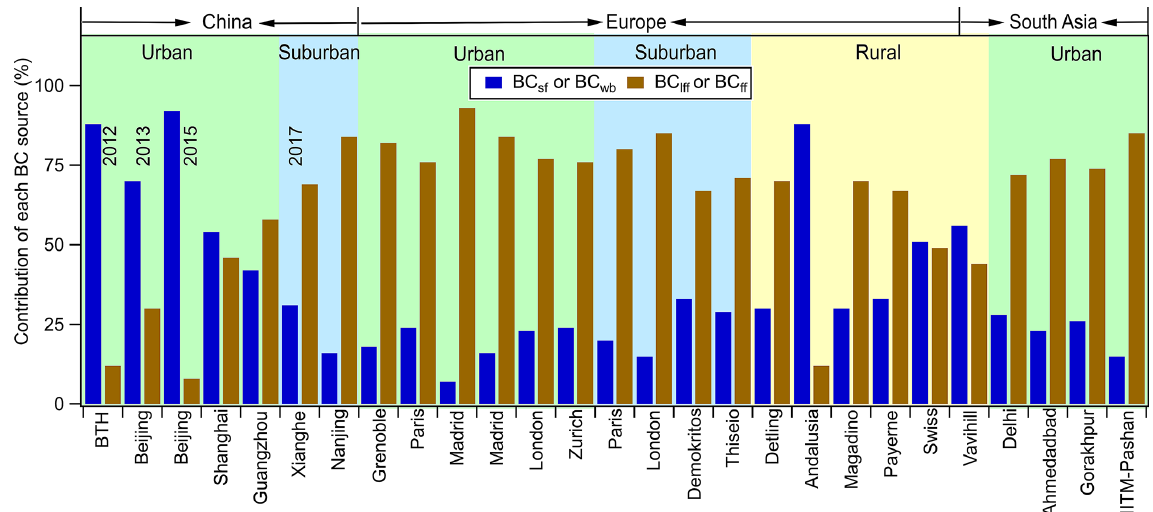
Figure 4. Comparisons of the different sources of black carbon (BC) in urban, suburban, and rural areas in China and Europe. BC sf and BC wb describe BC from solid fuel sources and wood burning, respectively. BC lff and BC ff represent BC from liquid fossil fuel and solid fossil fuel sources, respectively. Detailed information of the data is summarized in Table S1.